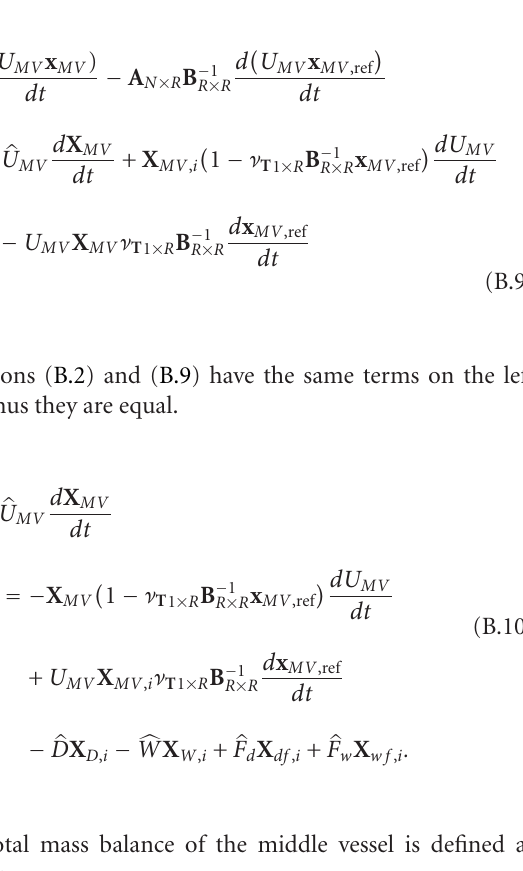
A : Matrix of stoichiometric coe ffi cients of the components in the reactions B : Matrix of stoichiometric coe ffi cients of the reference components D : Distillate flow rate (mol/s) d : Distillate component flow rate (mol/s)